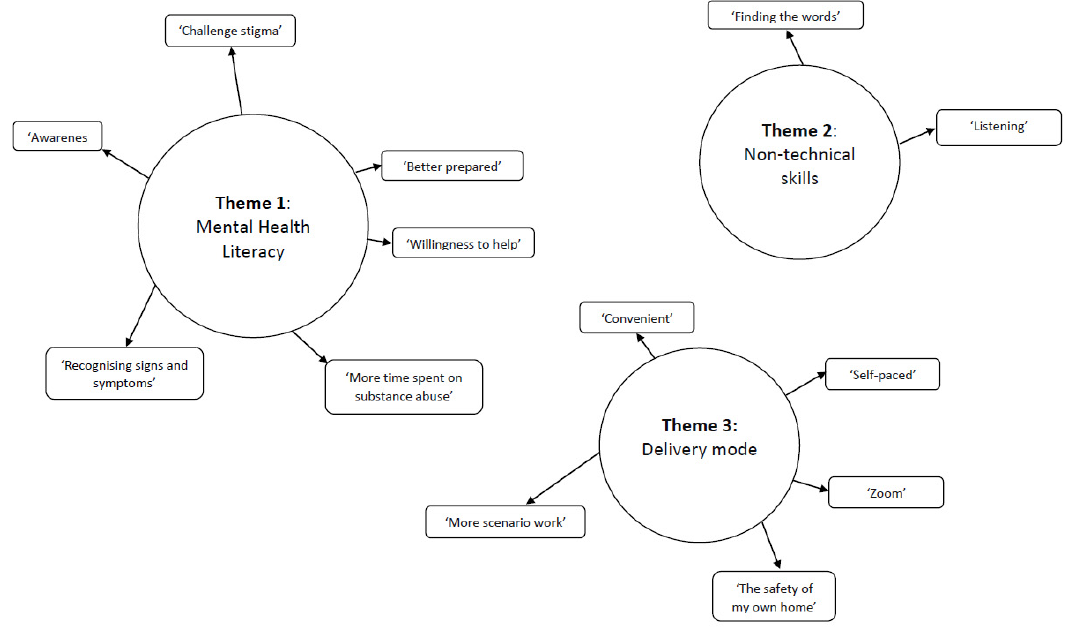
Figure 2. Final thematic